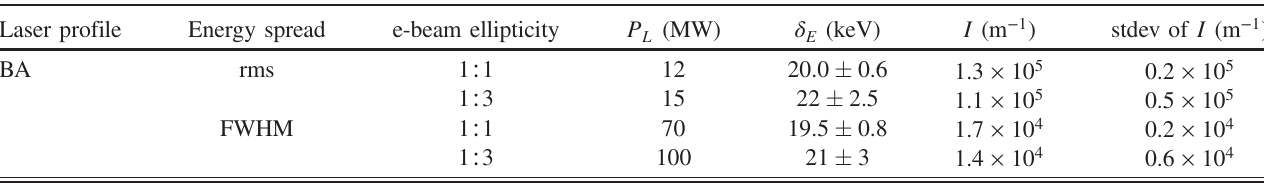
TABLE III. Energy spread and I values for BA for both rms and FWHM optimization. Laser